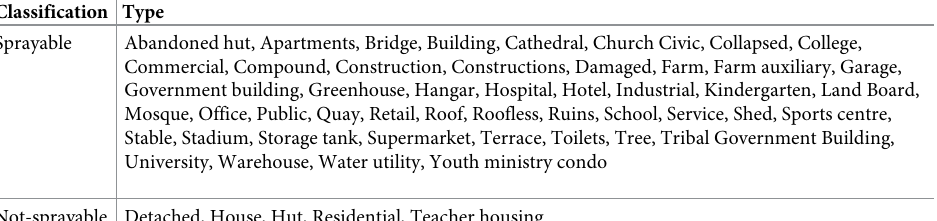
Table 1. Structure types of OSM buildings for Swaziland and Botswana combined and their respective binary clas- sification for modeling. Classification